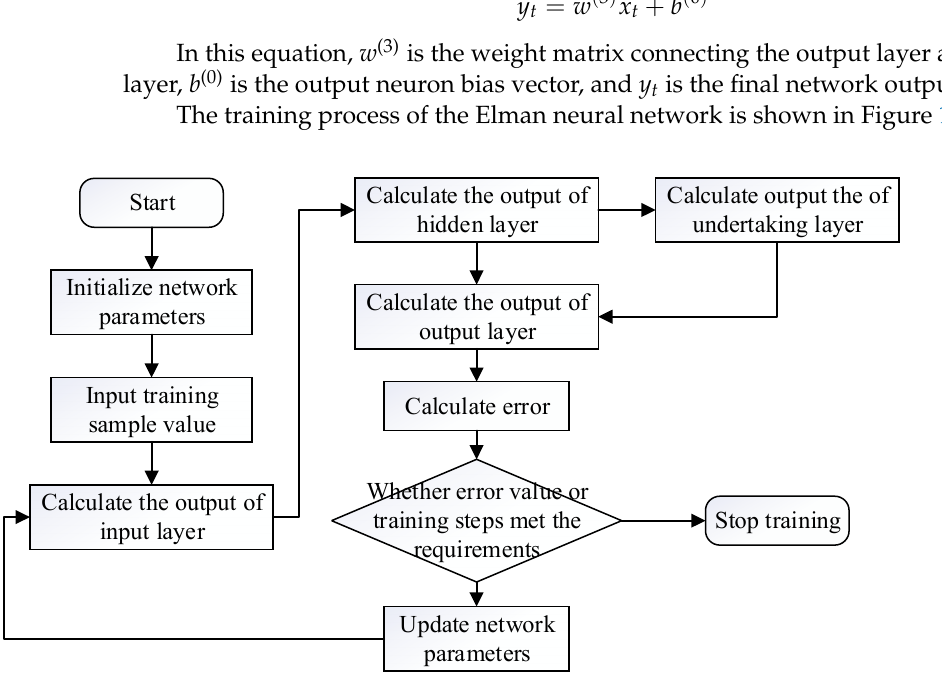
Figure 10. Elman neural network training process.